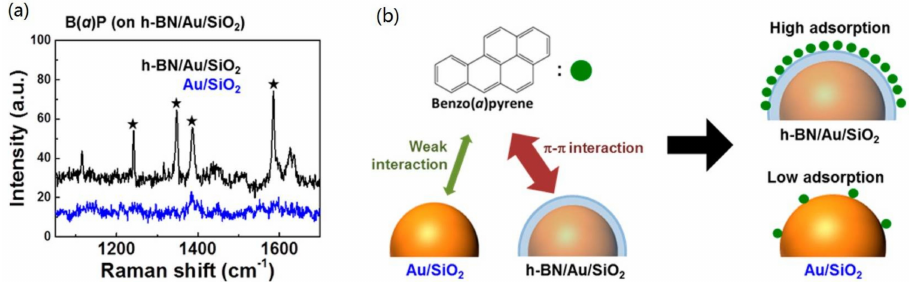
Figure 8. ( a ) SERS spectra benzo( α )pyrene on h-BN/Au/SiO 2 and Au/SiO 2 substrates; ( b ) schematic mechanism to explain SERS of benzo( α )pyrene on h-BN/Au/SiO 2 and Au/SiO 2 substrates. Reproduced from [74] with permission; Copyright ACS